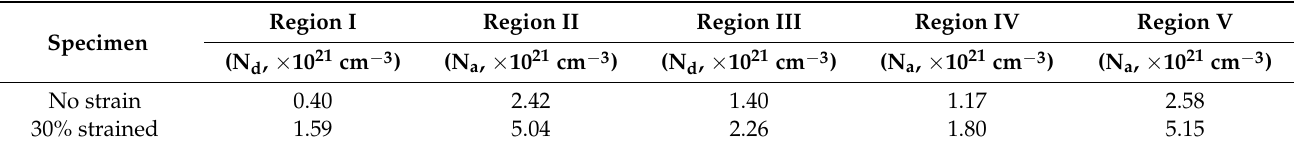
Table 3. Donor (N d ) and acceptor (N a ) densities in oxide films calculated from the Mott–Schottky analyses. Specimen